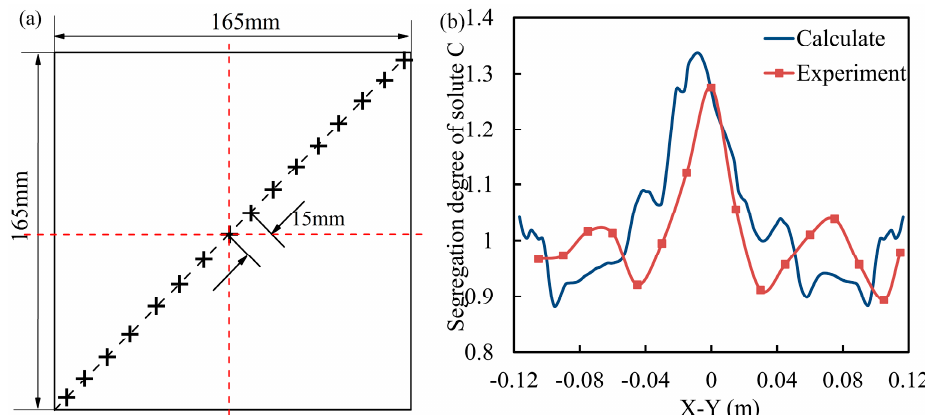
Figure 12. Validation of the model: ( a ) sampling scheme in experimental billet; and ( b ) comparison between the calculated and experimental segregation degree.